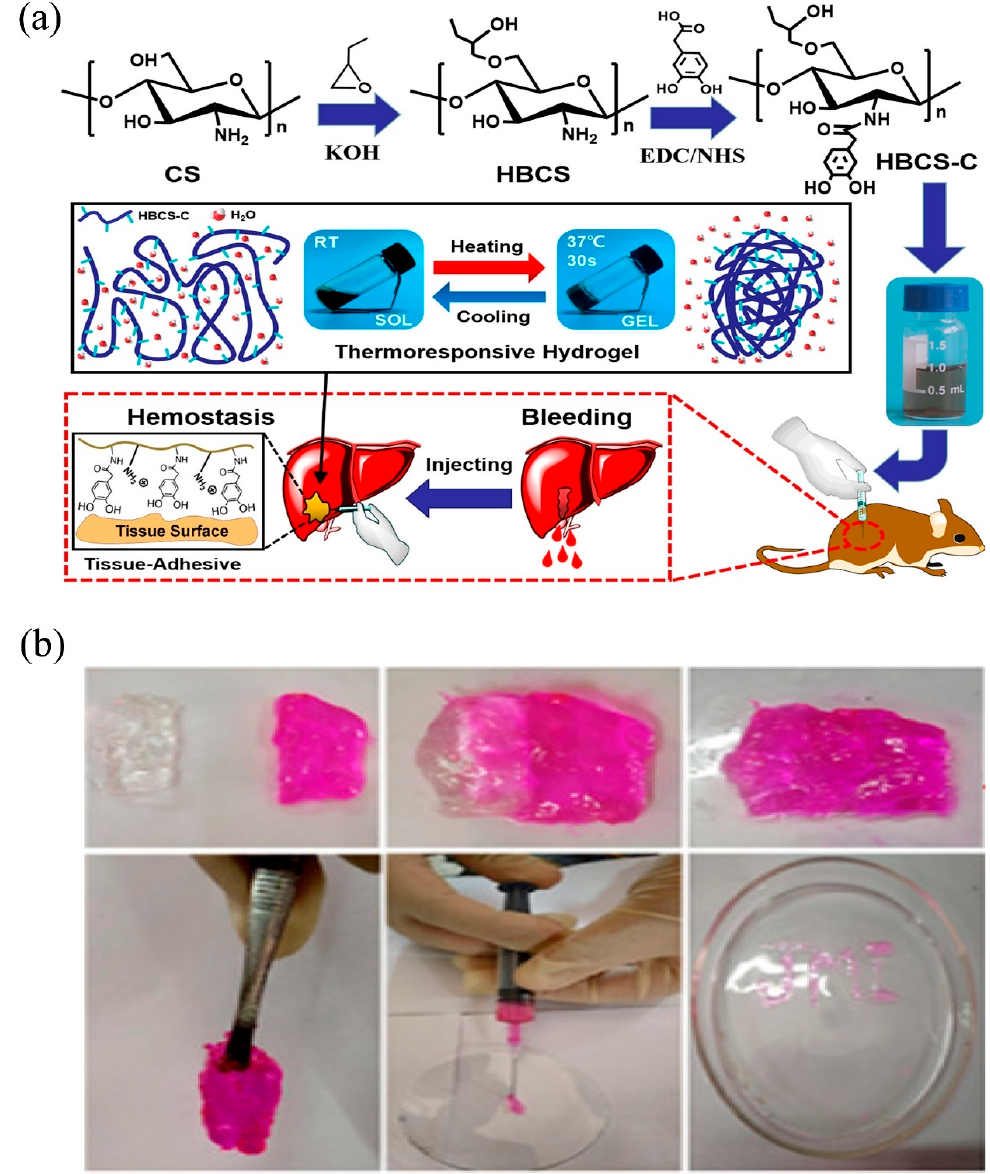
Figure 4. ( a ) Schematic diagram of the preparation, temperature-sensitive sol–gel transition, injec- tion, and adhesion of HBCS-C hydrogel towards the mice liver [100]. Copyright 2020 American Chemical Society. ( b ) SCS-GAMA hydrogels were cut in half (one part unloaded and the other part loaded with Rhodamine-B) at 2 and 6 h to diffuse and self-heal, and the self-healing properties of SCS-GAMA hydrogels were confirmed by lifting the hydrogels with forceps with extruded hydro- gels through a syringe [101]. Copyright 2020 American Chemical Society.